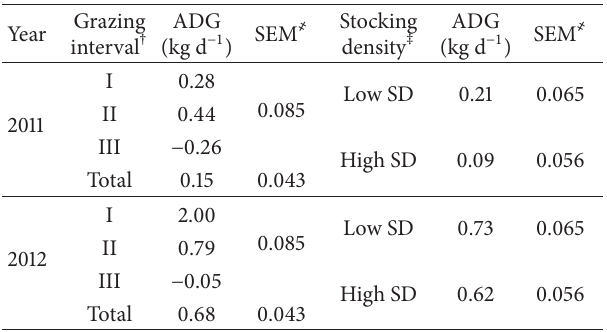
Table 8: Average daily gain by grazing interval and treatment over two years.